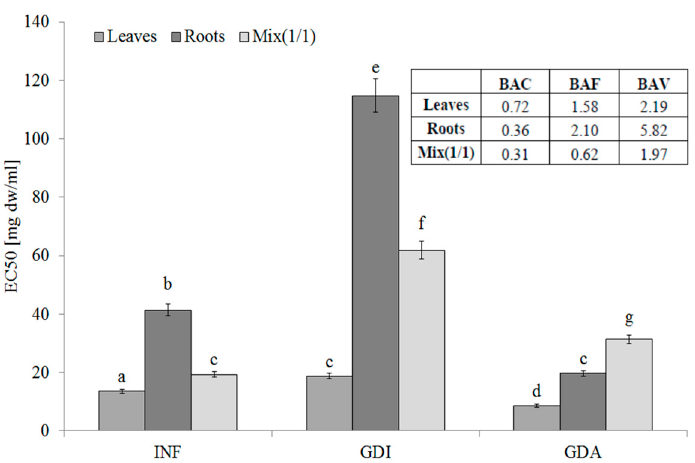
Figure 3. Lipoxygenase-inhibitory potential of extracts from the leaves and roots of S. aloides . INF —infusions, GDI—gastrointestinally digested extracts, GDA—samples after simulated absorption; BAC—the antioxidant bioaccessibility index, BAV—the antioxidant bioavailability index, BEF—the antioxidant bioefficiency index. Standard deviation (SD) is shown as error bars. Values (±SD) with different letters (a–g) are significantly different at p < 0.05.